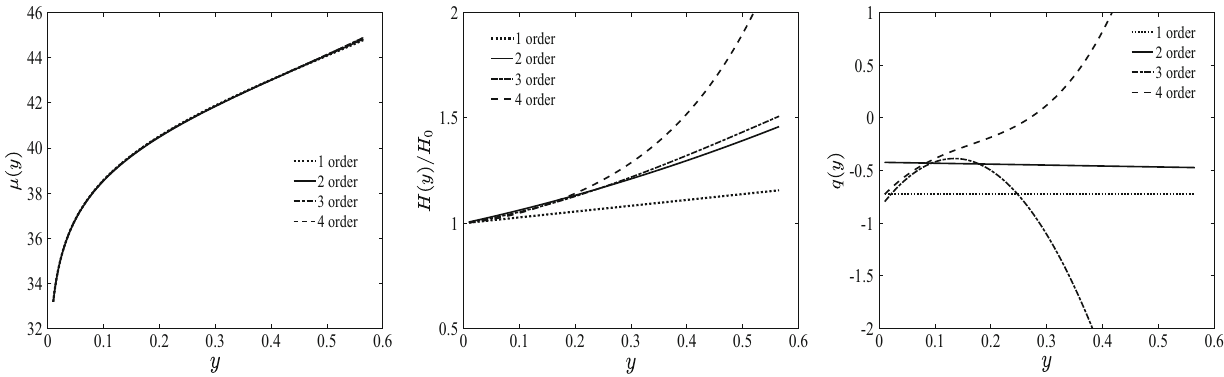
Fig. 8 Cosmographic distance modulus, Hubble parameter and deceleration parameter with different orders in the y